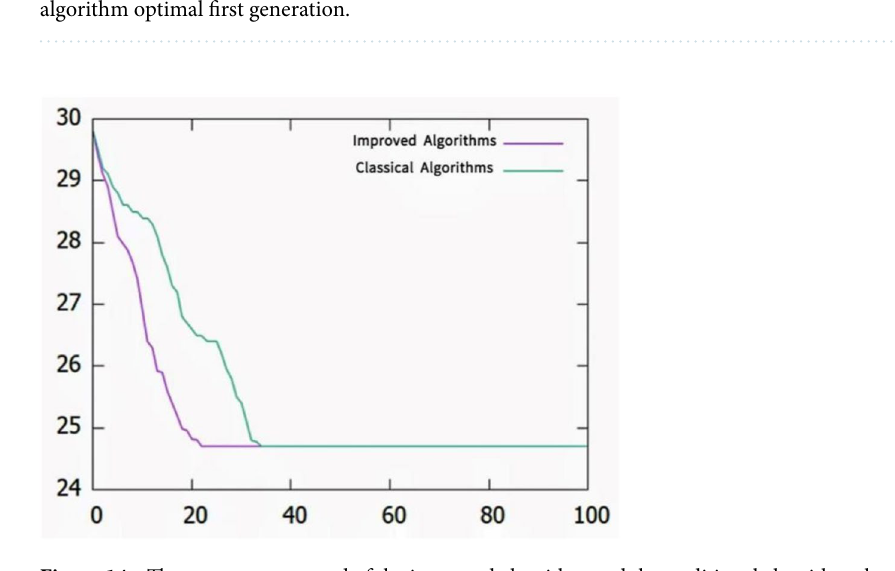
Figure 14. The convergence trend of the improved algorithm and the traditional algorithm shows that the improved algorithm has obvious advantages in solution stability and convergence